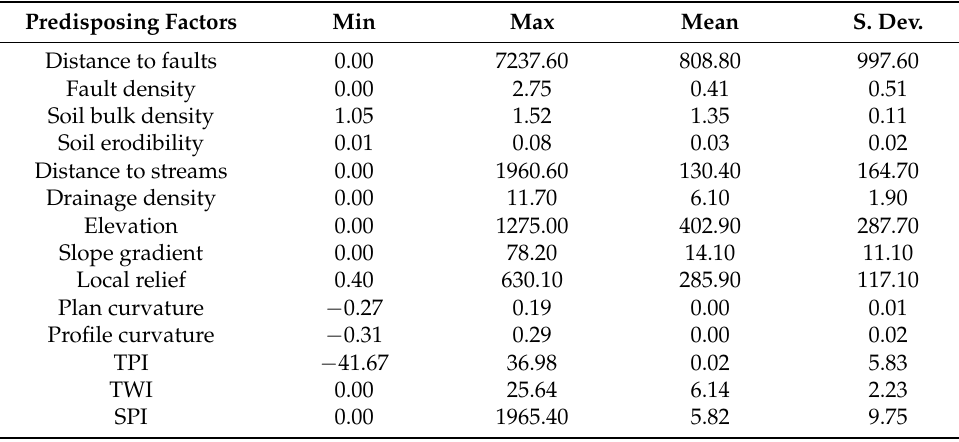
Table 2. Descriptive statistics of the continuous predisposing